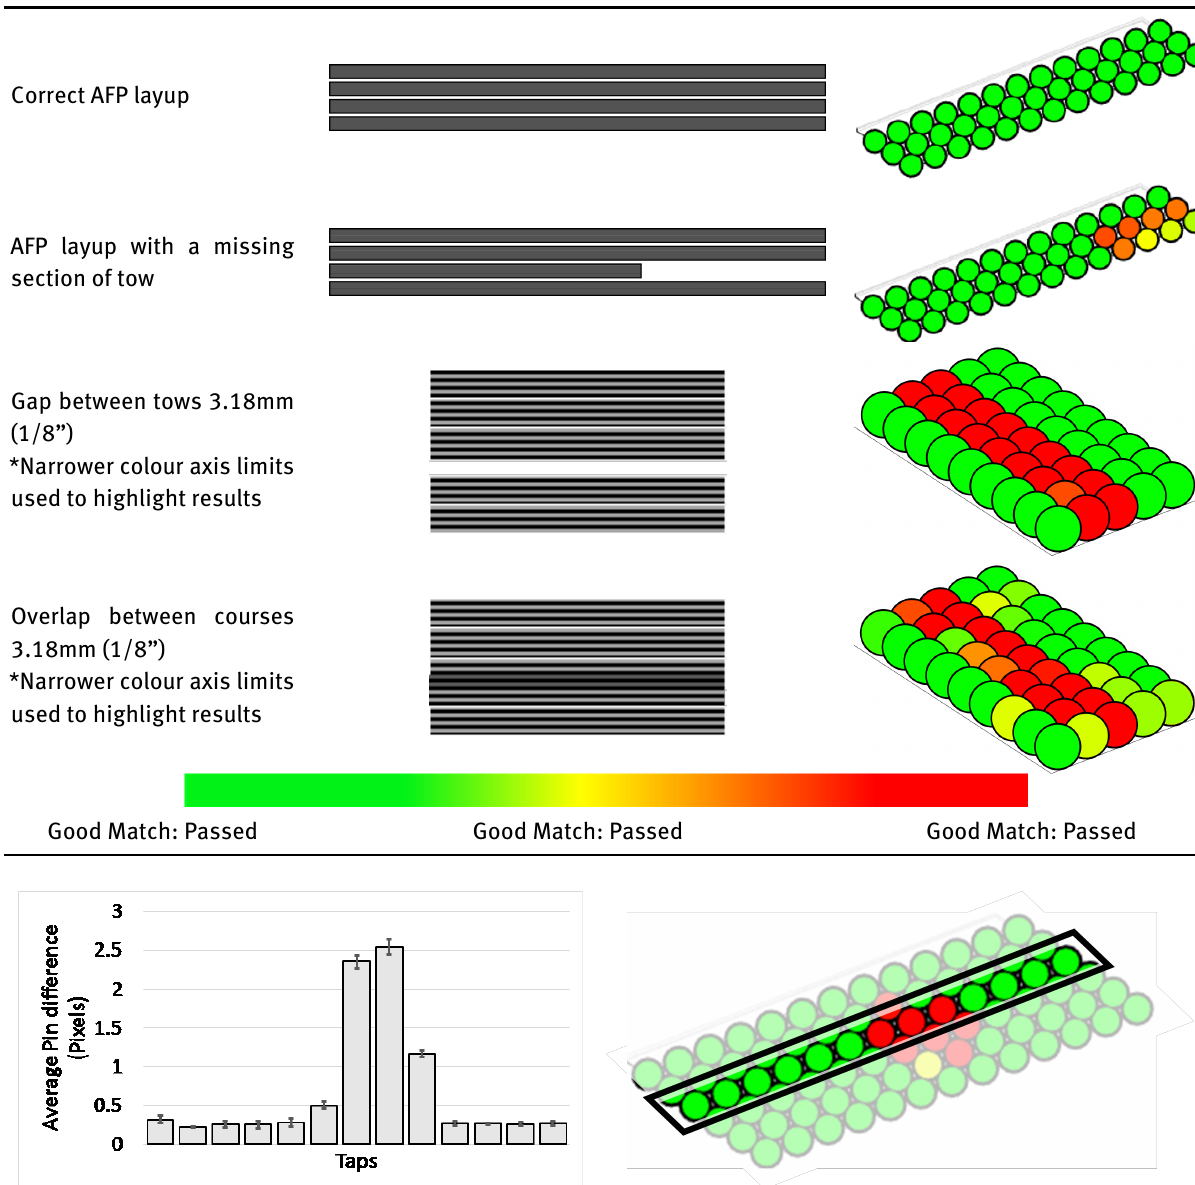
Figure 7: (Left) Selection of tap data presented with error bars showing the standard deviation across five samples. (Right) Illustration showing location of these selected taps, for the full plot see Table